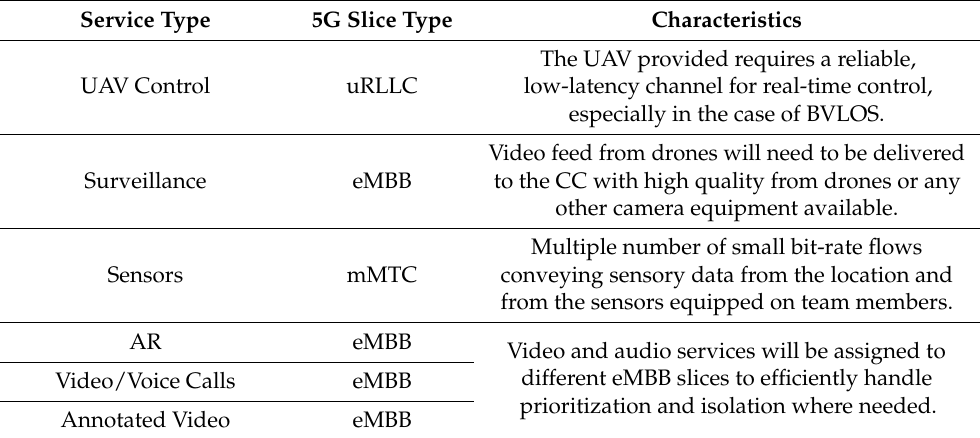
Table 1. Mapping of 5G Slices to Emergency